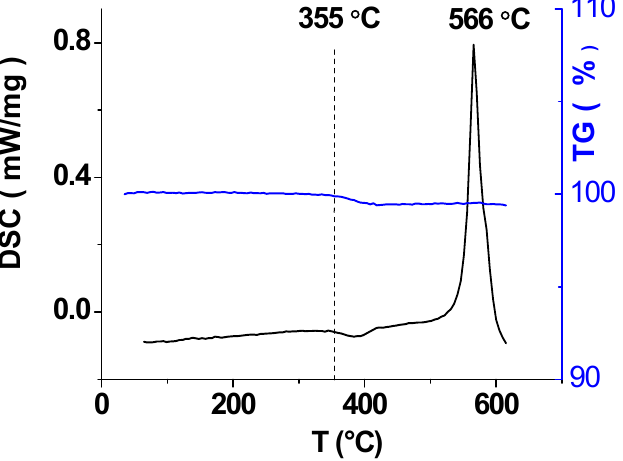
Figure 7. DSC (black line) and TG (blue line) curves for Li 1.3 V 3 O 8 and Li 3.8 Ge 0.9 S 0.1 O 4 solid electrolyte powders (mass ratio 1:2).